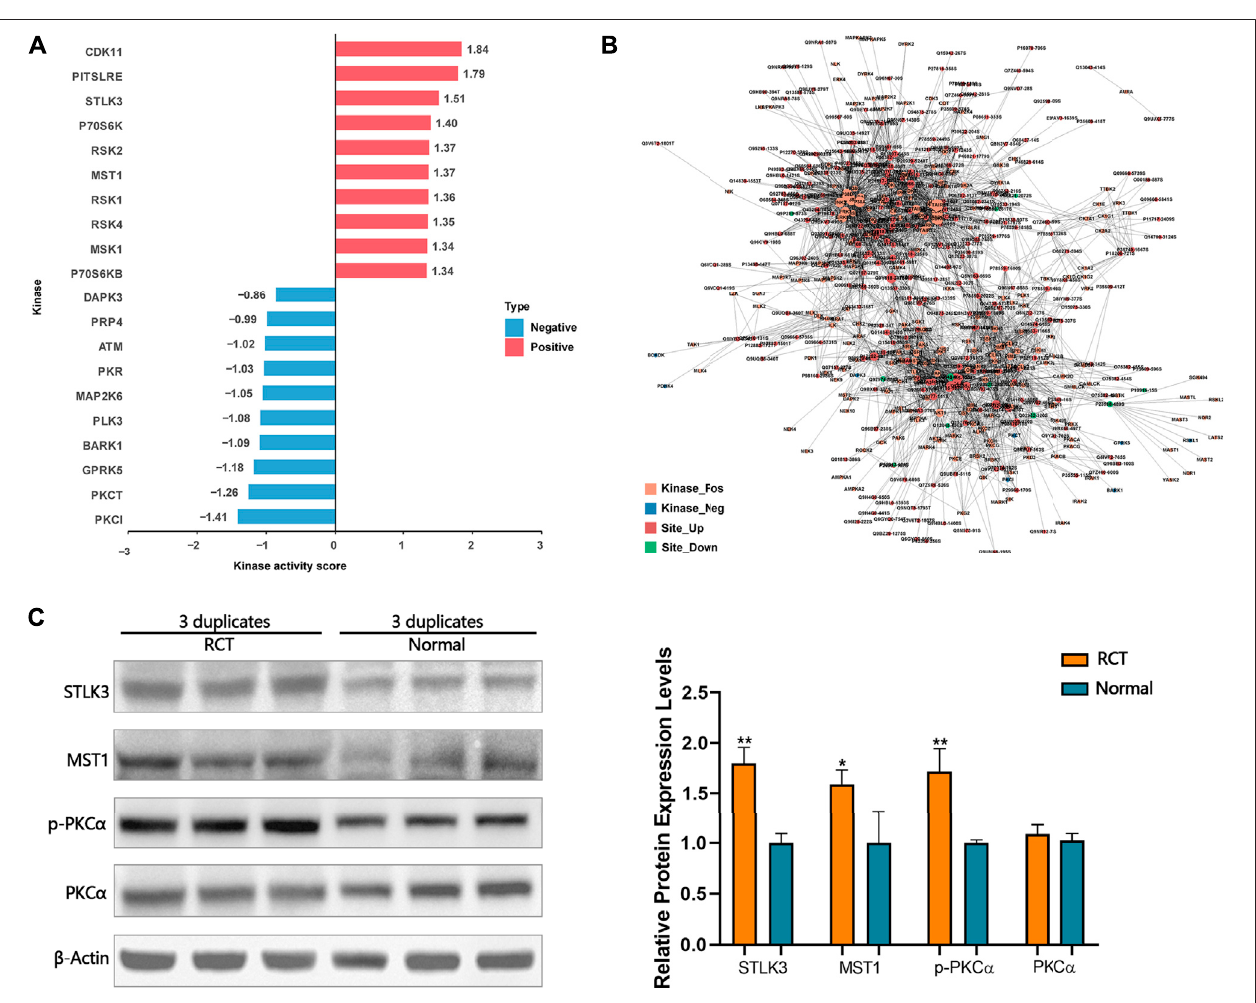
FIGURE4|(A) Someactivated andinactivated protein kinasewerepredicted byiKAP. (B) Accordingtothekinase-sitephosphorylationnetwork,phosphorylation levels ofPKC α that wasenriched inWntpathway at T497were positively correlated withSTLK3 and MST1. (C) Western blotting validation. Differential expression levels of STLK3, MST1, and p -PKC α in RCT and normal tissues were veri fi ed using western blotting analysis. Paired samples t -test was used. * p < 0.05, ** p <